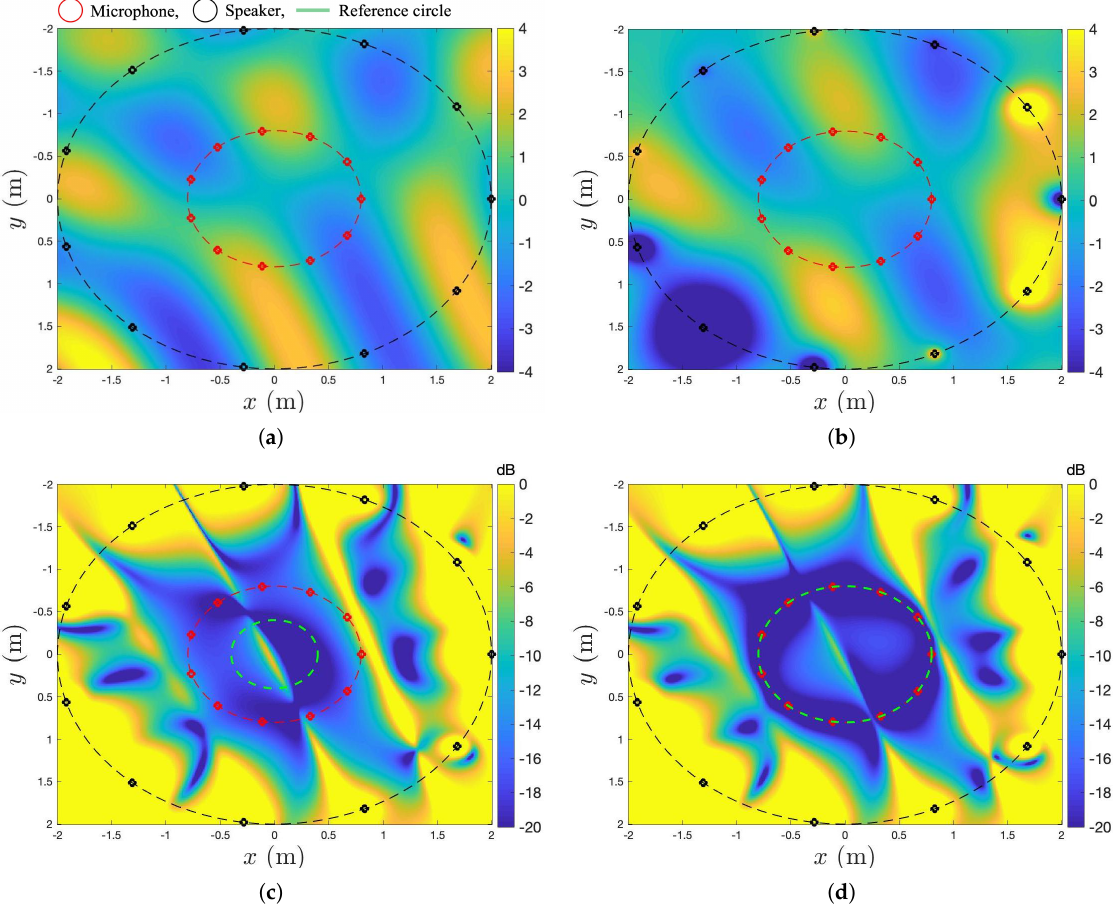
Figure 4. ( a ) Desired wave field. ( b ) Wave field reproduction based on the use of a circular array. Wave field reproduction error at ( c ) r ref = 0.4 m and ( d ) r ref = R mic